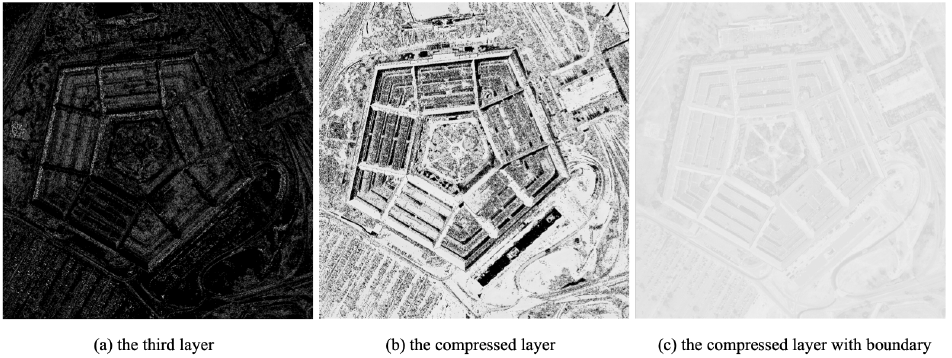
Figure 7. The comparison of preprocessed results of image “3.2.25”.